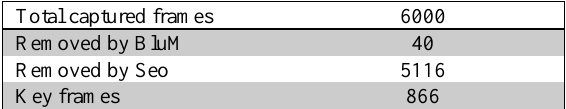
Table 3. Results of key frame selection.